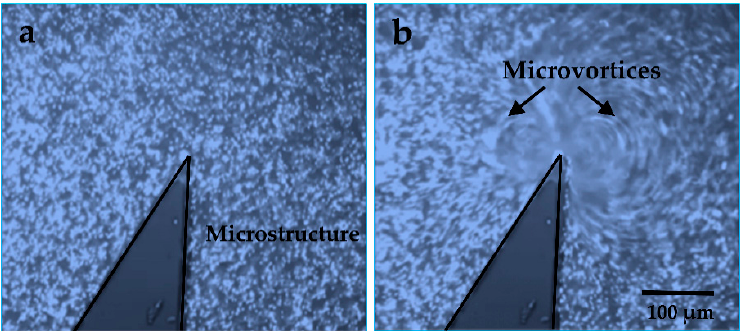
Figure 3. Experimentally observed trajectories of the 1 μ m diameter fluorescent beads in our acoustically vibrated microstructure: ( a ) the driving voltage is 0 V p-p , while in ( b ), the driving voltage is 20 V p-p .